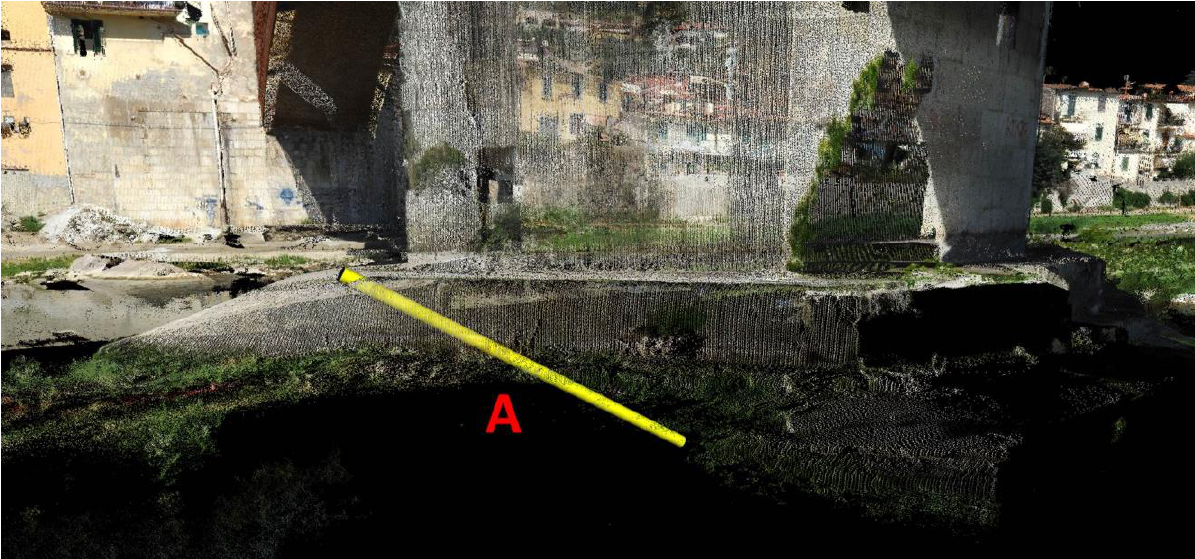
Figure 4 - Visualization of the Inclined borehole (a) on the central pillar's coloured point cloud. Inspection detected a vacuity inside the pillar structure.